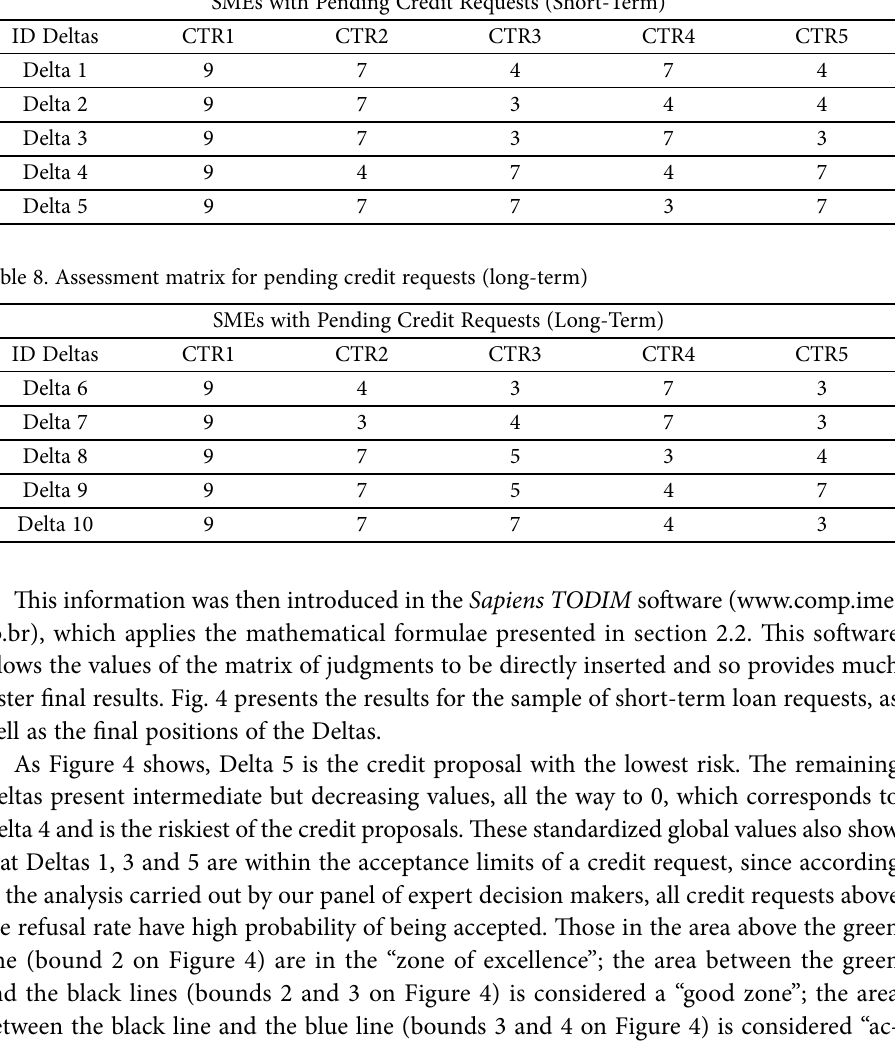
Table 7. Assessment matrix for pending credit requests (short-term) SMEs with Pending Credit Requests (Short-Term)